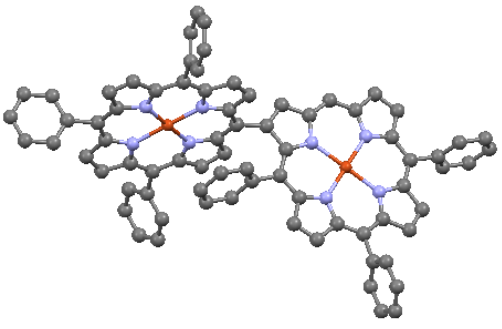
Figure 21. Directly meso - β linked Cu-diporphyrin, from data in [7,57]. Red = Cu.